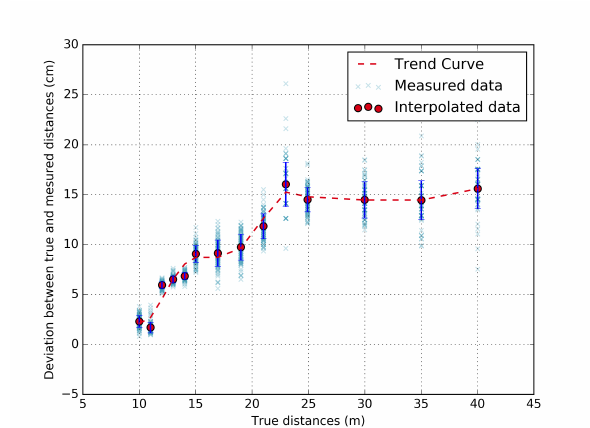
Figure 10: Deviations of measured distances with respect to true distances (outdoor) The indoor and outdoor measurements have relatively different results (Figure 9, Figure 10). Indeed, on the common range be- tween 10 meters and 14 meters , for the indoor acquisition, dis-